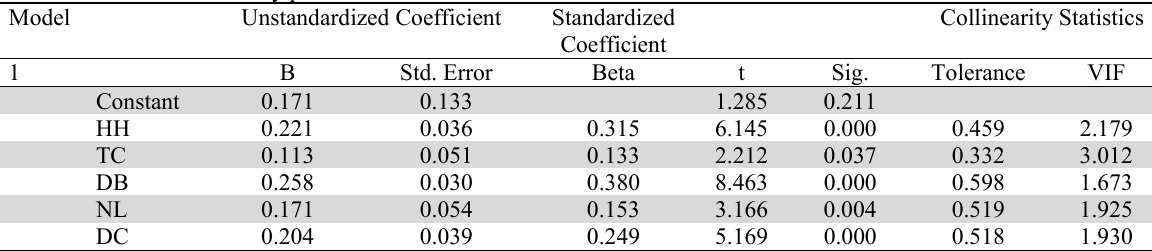
Evaluate the multi-collinearity phenomenon of the model Model Unstandardized Coefficient Standardized